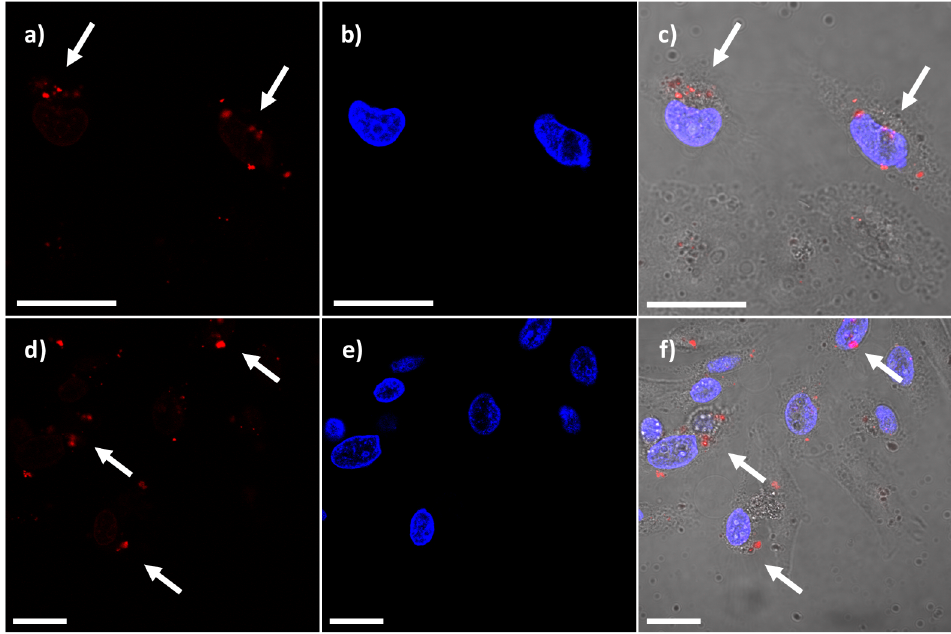
Figure 5. Confocal micrographs of HeLa cells incubated in the presence of 20 µg/mL of AlClPc-MSNs and AlClPc/cisplatin-MSNs for 4 h at 37 °C. ( a and d ) Red fluorescence from the internalized AlClPc-MSN and AlClPc/cisplatin-MSN materials; ( b and e ) DAPI-stained nuclei; and ( c and f ) overlapped image of DAPI-stained nuclei, red fluorescence, and DIC channel. White arrows indicate the localization of MSN materials. Scale bar = 20 μ